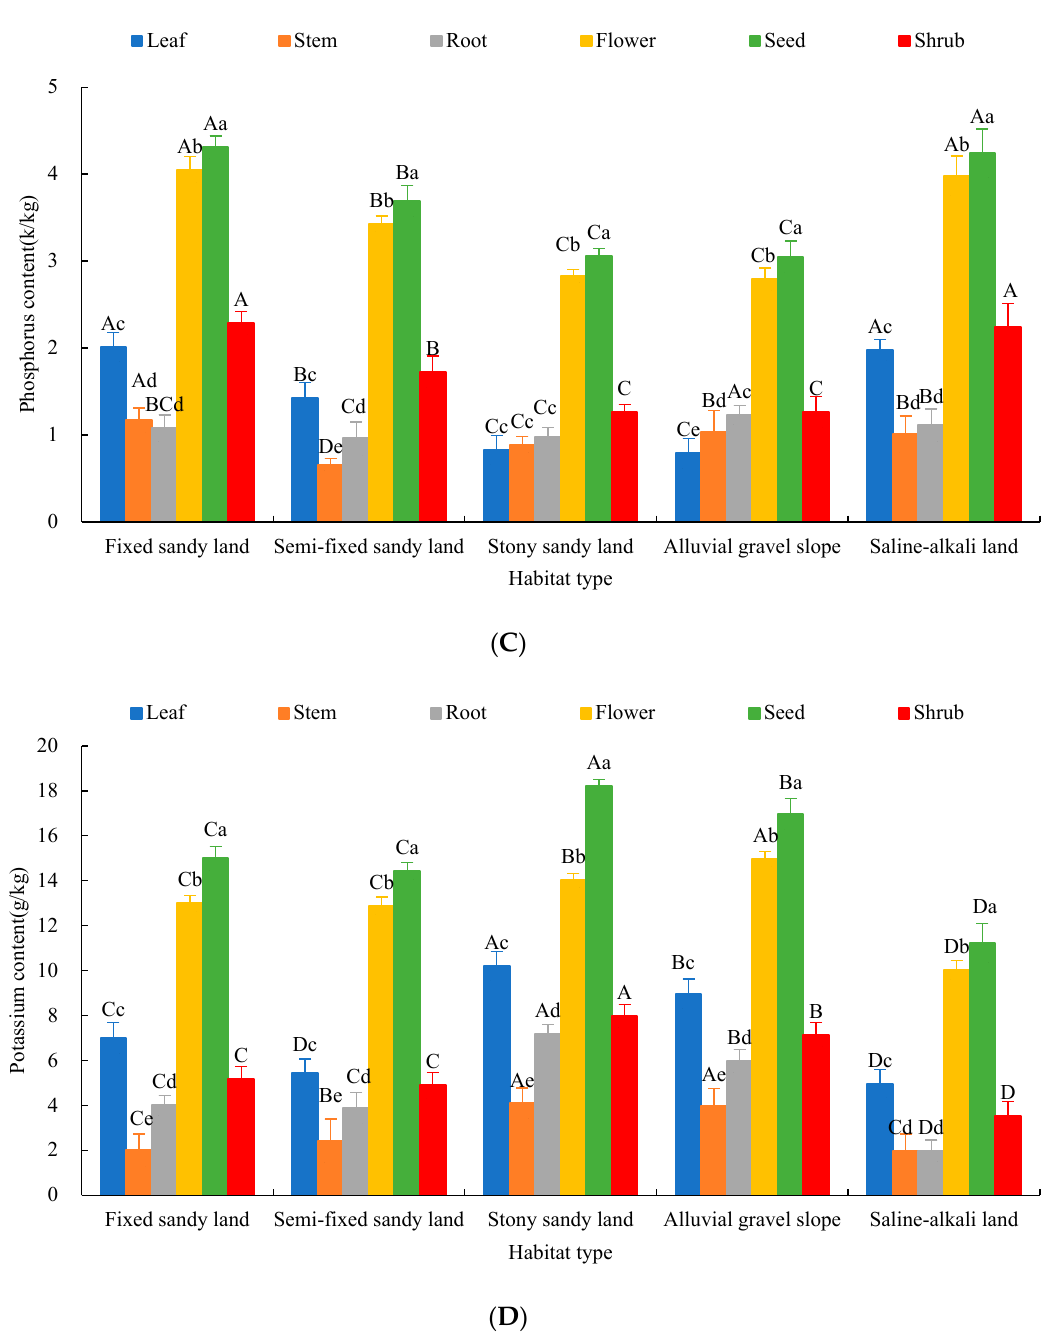
Figure 1. Carbon ( A ), Nitrogen ( B ), Phosphorus ( C ) and Potassium ( D ) concentrations in the organs of A. mongolicus in different habitats. Note: Upper case letters represent significant differences in different habitats of the same organ ( p < 0.05). Lower case letters represent the significant characteristics of different organs in the same habitat ( p < 0.05).